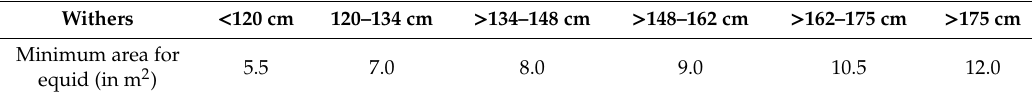
Table 9. Minimum measurements for collective